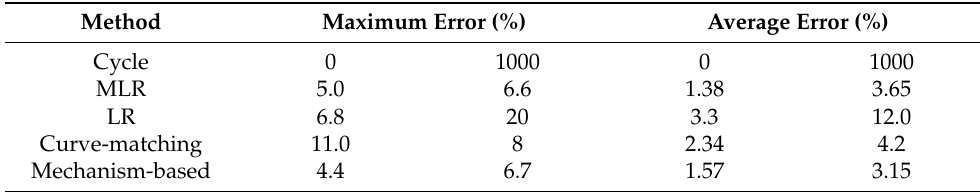
Table 2. Error statistics table for three methods.